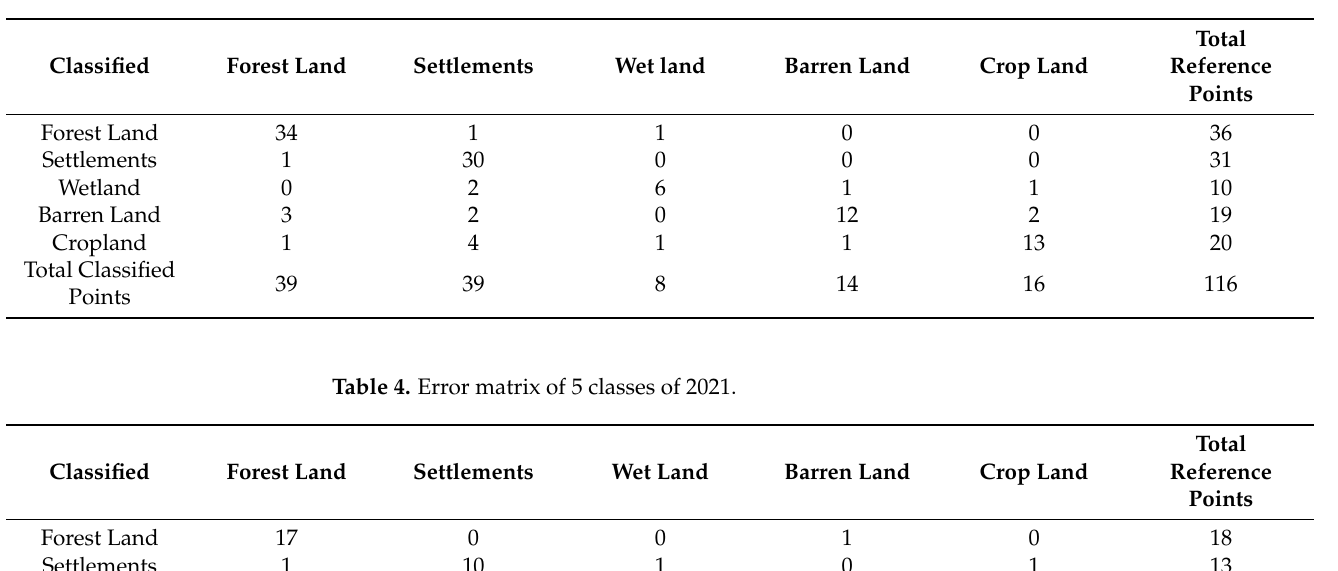
Table 3. Error matrix of 5 classes of 2011.